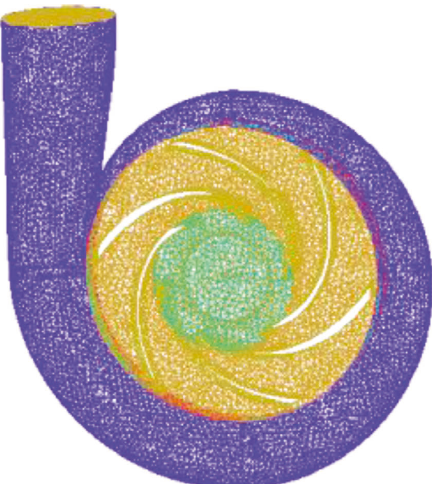
Figure 4: Volute hydraulic model.